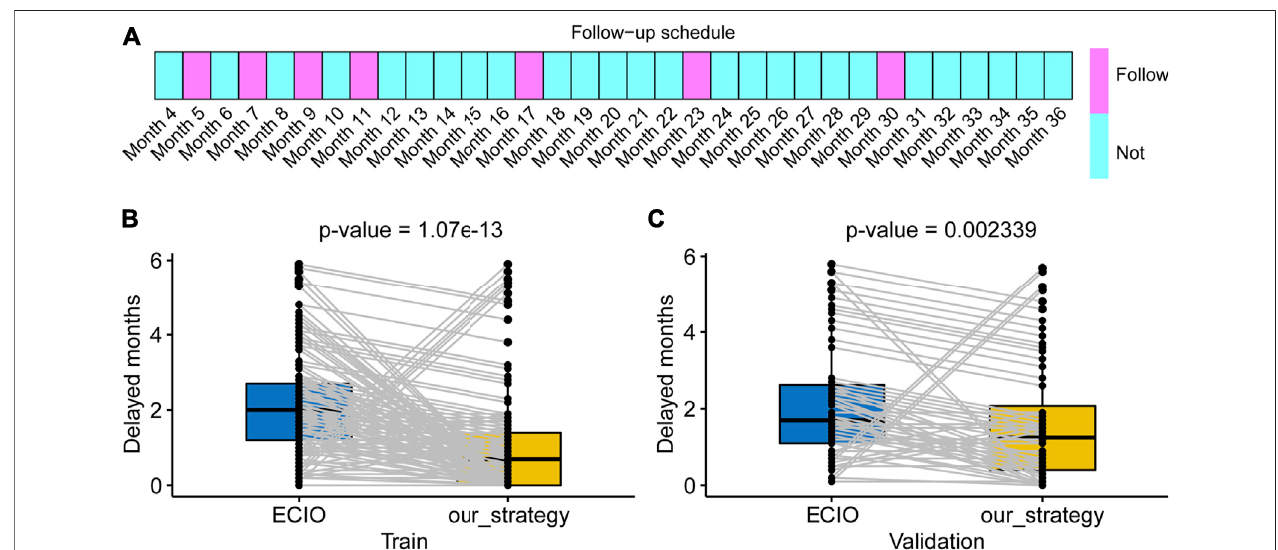
FIGURE 5 | Our schedule and the clinical application. (A) The boxes panel show the months that should be followed. (B,C) Our schedule produces less delayed detection in both the train and validation cohorts. ECIO: European Conference on Interventional